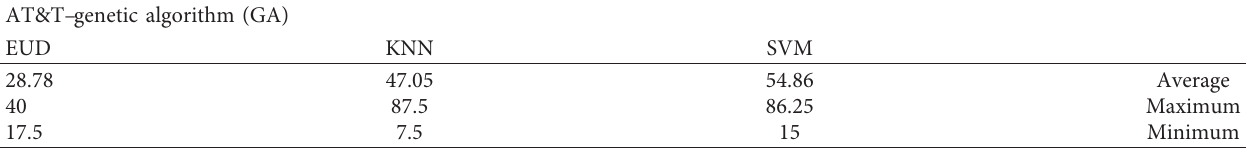
Table 6: Recognition accuracies for the AT&T database with the GA algorithm.